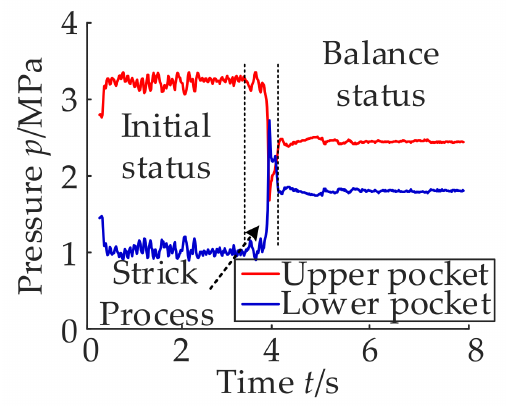
Figure 15. Oil pocket pressure by test when K p = 30.